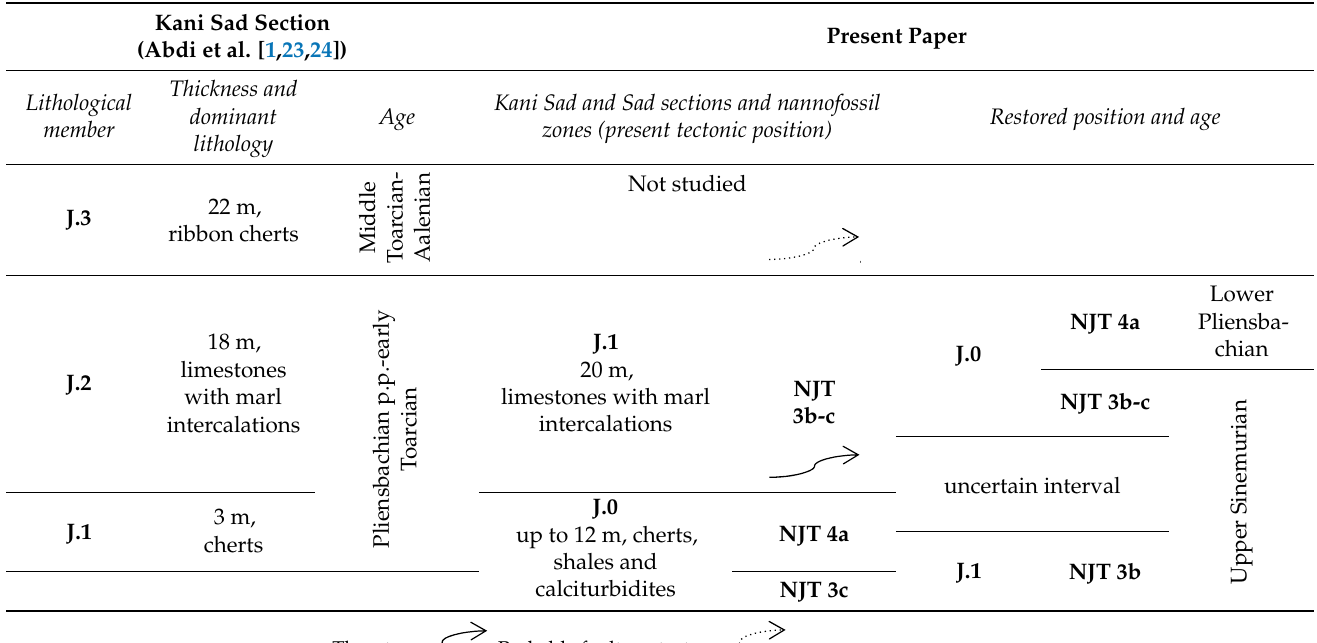
Table 1. Synthesis of the stratigraphic members described in the studied Kermanshah area in previous and present work.